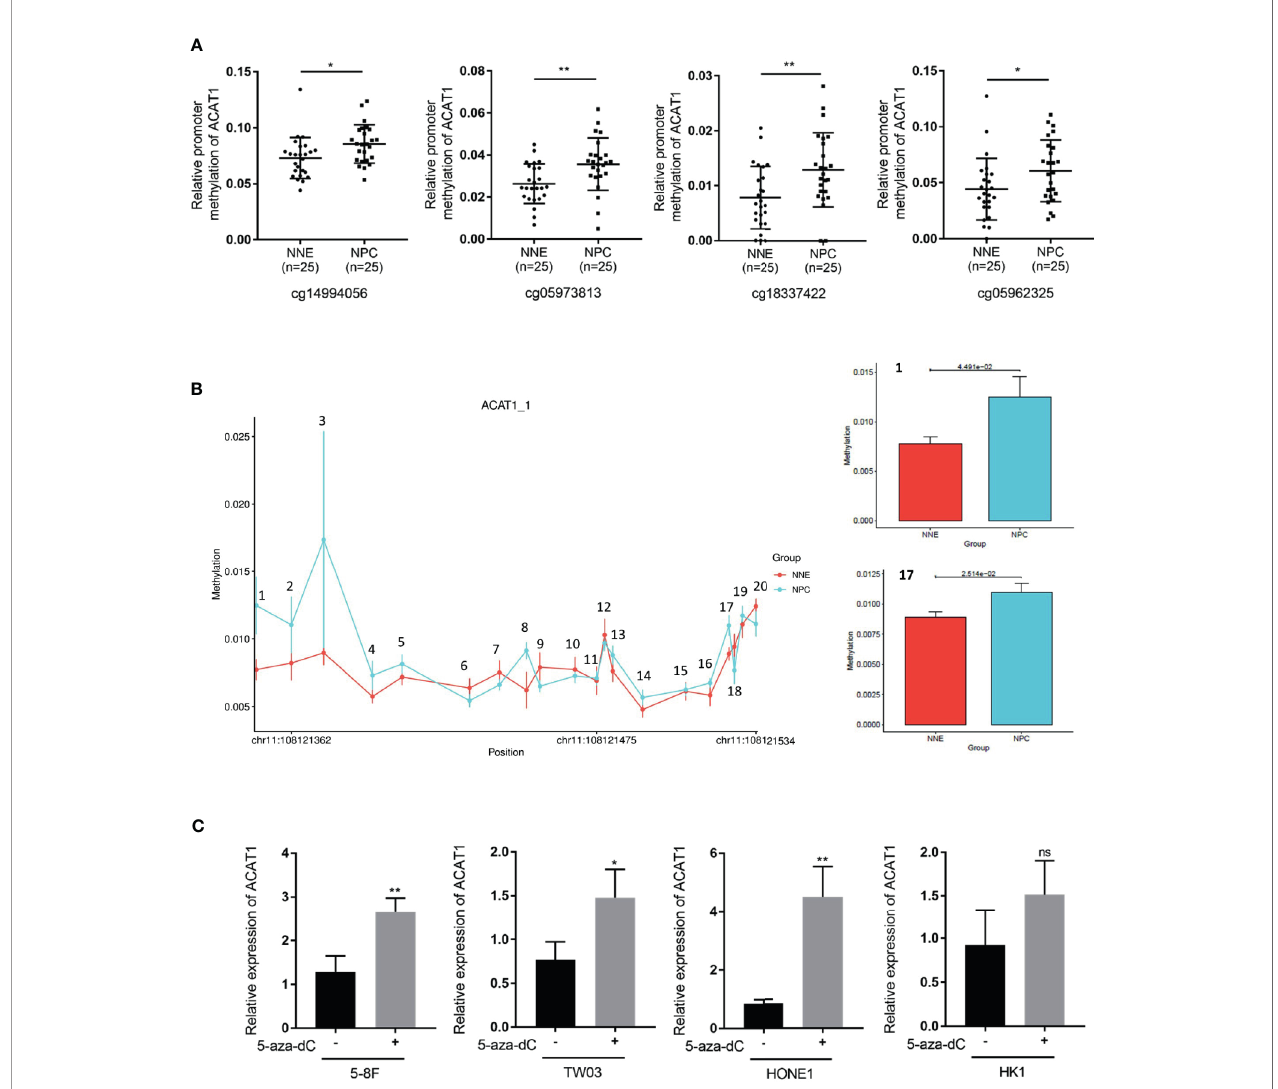
FIGURE 3 | DNA hypermethylation of the ACAT1 CpG island in NPC tumor biopsies and normal nasopharyngeal tissue. (A) DNA methylation microarray data (GSE62336) containing 25 cases of NPC primary tissues and 25 cases of normal nasopharyngeal epitheliums was used for analyzing the relative methylation level in the CpG island of the ACAT1 gene. Four probes targeting the CpG island region of ACAT1 were found. The dot plot shows the relative methylation level of the ACAT1 gene. (B) The methylation status of the 20 CpG sites within the ACAT1 gene promoter in 20 NPC biopsies and 9 normal nasopharyngeal epithelium biopsies were analyzed by bisul fi te genomic sequencing. (C) Real-time RT-PCR analysis of the mRNA level of ACAT1 in four NPC cell lines with and without treatment with 5- aza-dC, 5 m M/L for 4 days. The independent Student ’ s t-test was used to analyze the results and data are expressed as the means ± SD. * p < 0.05, ** p <